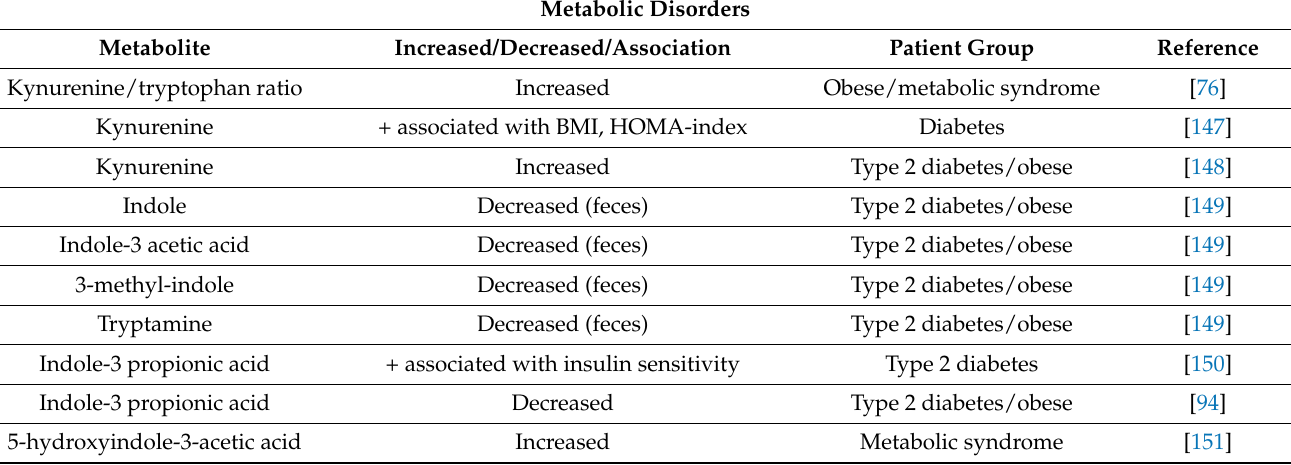
Table 1. Altered levels of tryptophan-derived metabolites and associations with clinical outcomes in metabolic, cardiovascular, and chronic kidney